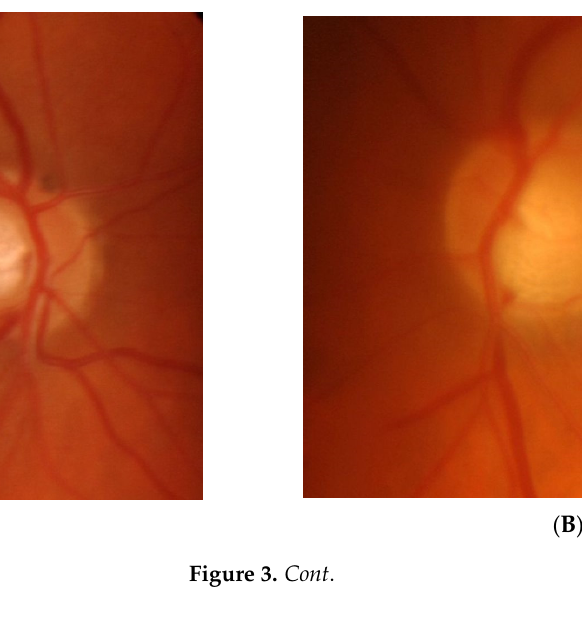
( D ) Figure 3. An 82-year-old male with pituitary gland adenoma. ( A ) Optic disc right eye. ( B ) Optic disc left eye. ( C ) Visual field right eye 05.2015 at initial visit. ( D ) Visual field left eye 05.2015 at initial visit. 2.4. Case 4 Figure 4: A 65-year-old hyperopic female was referred to our clinic because she de- veloped left eye pallor with consistent VF loss. Her BCVA was 1.0 with correction +4.5 DSph and 0.5+ with correction +4.5 DSph, right and left eye, respectively. The IOP was 15 and 16 mmHg, right and left eye, respectively. Her angle in gonioscopy was narrow (I/II deg.), but neither acute nor prodromal glaucoma were confirmed, which is why an MR was performed. It revealed a left optic nerve sheath meningioma measuring 11 × 12 × 7 mm involving optic nerve canal. The tumor was totally removed by left craniotomy and pathology confirmed a diagnosis of psammomatous meningioma. The patient is stable and continuously observed; the BCVA 2 years after surgery is the same, 1.0 and 0.4, right and left eye, respectively.